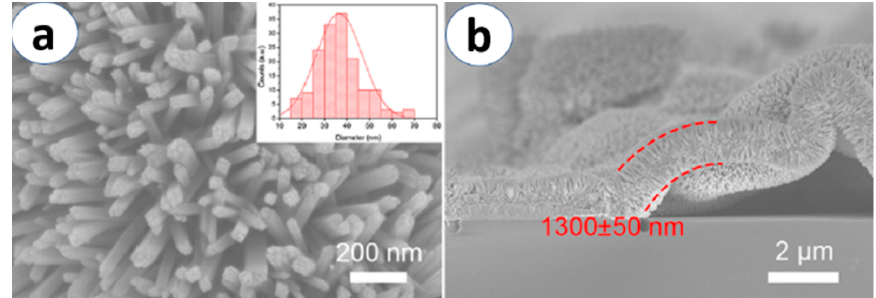
Figure 4. SEM images of TiO 2 nanorods prepared using the hydrothermal method. ( a ) Top and ( b ) cross-sectional views of the nanorods. Reprinted with permission from Ref. [44] ACS Copyright 2020.